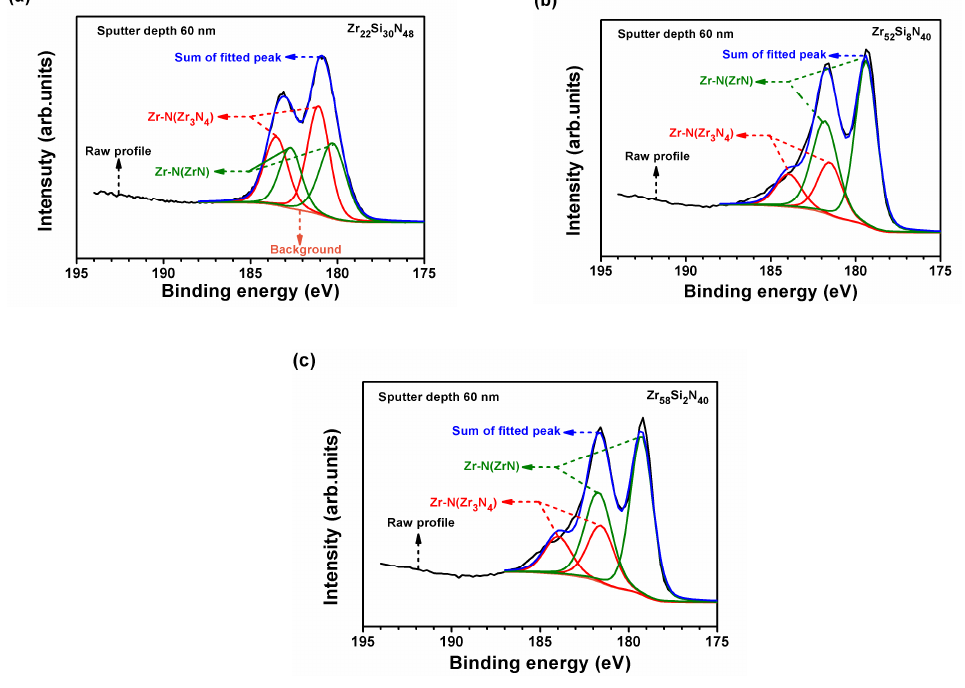
Figure 6. XPS profiles of Zr 3d core levels of ( a ) Zr 22 Si 30 N 48 (0.4,R5); ( b ) Zr 52 Si 8 N 40 (0.4,R5); and ( c ) Zr 58 Si 2 N 40 (0.4,R5) coatings at a depth of 60 nm.